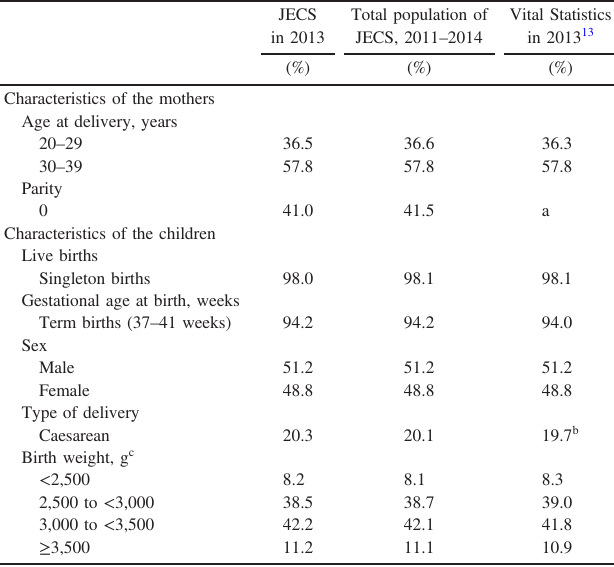
Table 5. The selected characteristics of the Japan Environment Children ’ s Study (JECS) and the national Vital